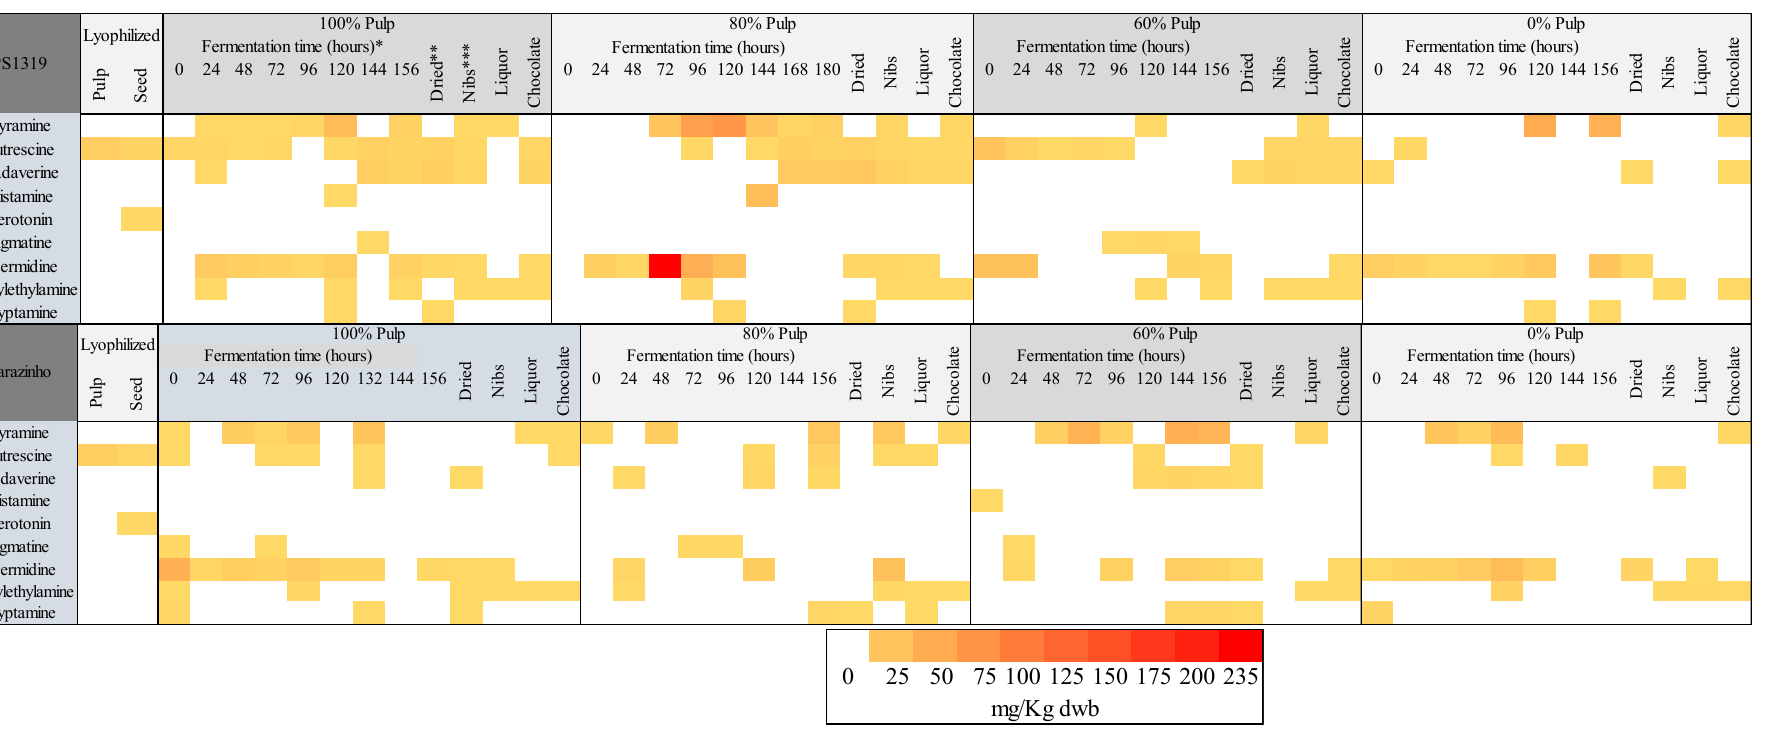
Figure 6. Heatmap representing free bioactive amine levels in cocoa and chocolate processing of two cacao varieties (PS 1319 and Parazinho) from Bahia, Brazil, using different pulp ratios (100, 80, 60, and 0%). * Fermentation time: cocoa seeds collected during the fermentation stage in different times. ** Dried: cocoa beans fermented and dried. *** Nibs: fermented and dried seed and roasted without the peel or germ.